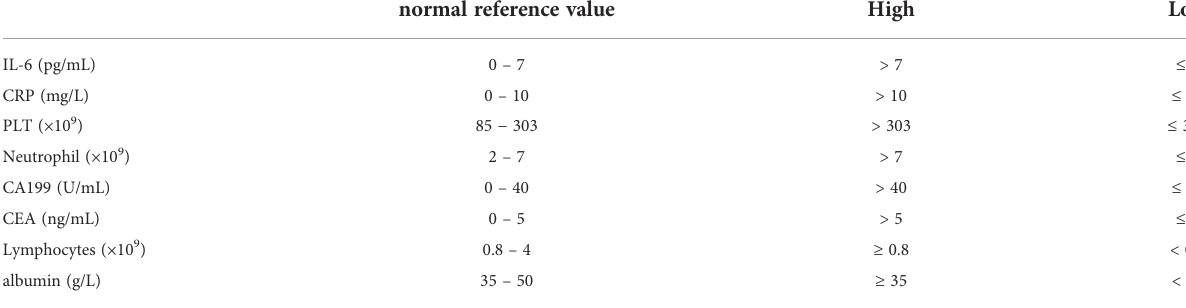
TABLE 1 The normal reference and cutoff values of serum markers.